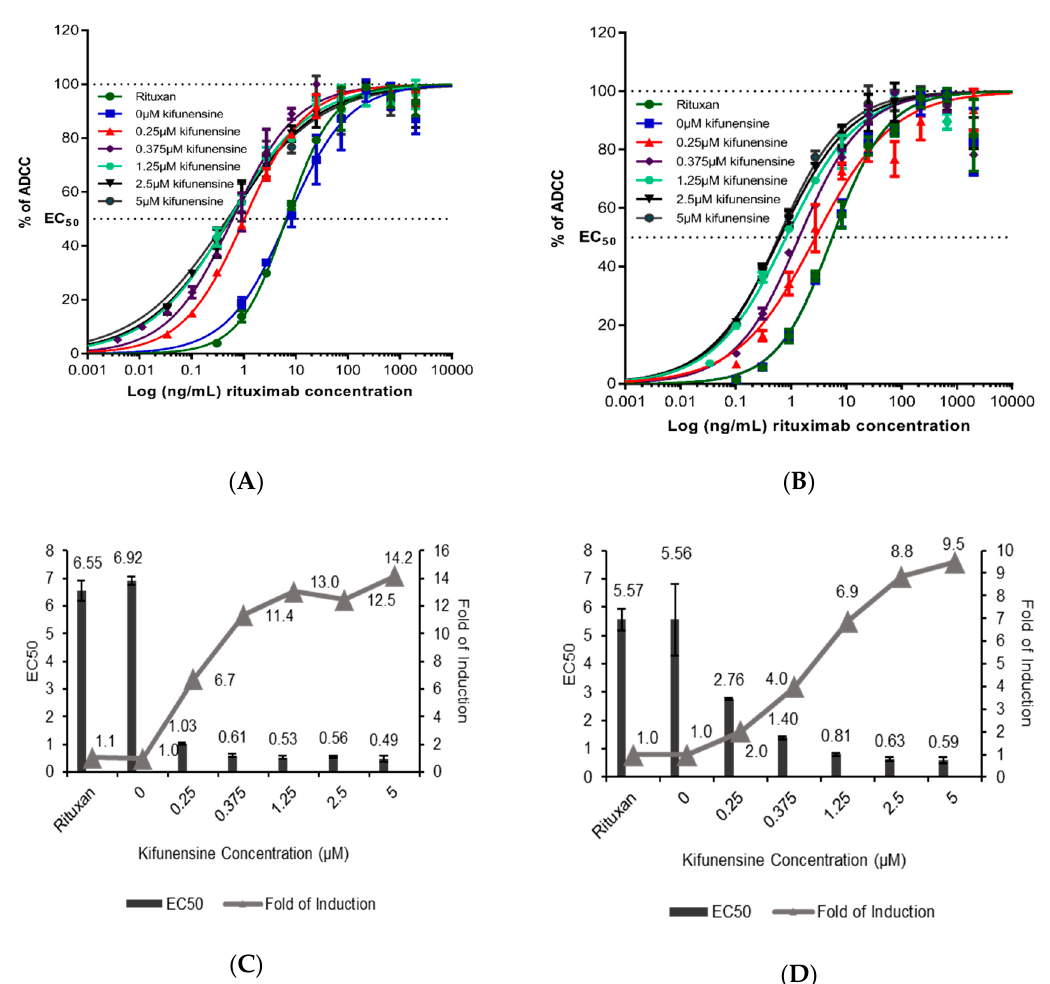
Figure 5. Antibody ‐ dependent cell ‐ mediated cytotoxicity of rituximab samples expressed in the presence or absence of kifunensine. Assay was performed using Wil2 ‐ S target cells along with either high affinity V/V 158 Fc γ RIIIa variant ( A , C ) or low affinity F/F 158 Fc γ RIIIa variant ( B , D ) engineered Jurkat cells. The effector cell: target cell ratio was 10:1. Values are expressed as normalized RLUs ( A , B ) and represent the mean ± Standard Deviation (SD). for triplicate analyses. Summary of ADCC activity represented as EC 50 values. The horizontal dotted defines 100% and 50% value ( C , D ), normalized to the control 0 uM kifunensine control value, indicating relative activity. The error bars of each EC 50 value correspond to the standard error of the mean.